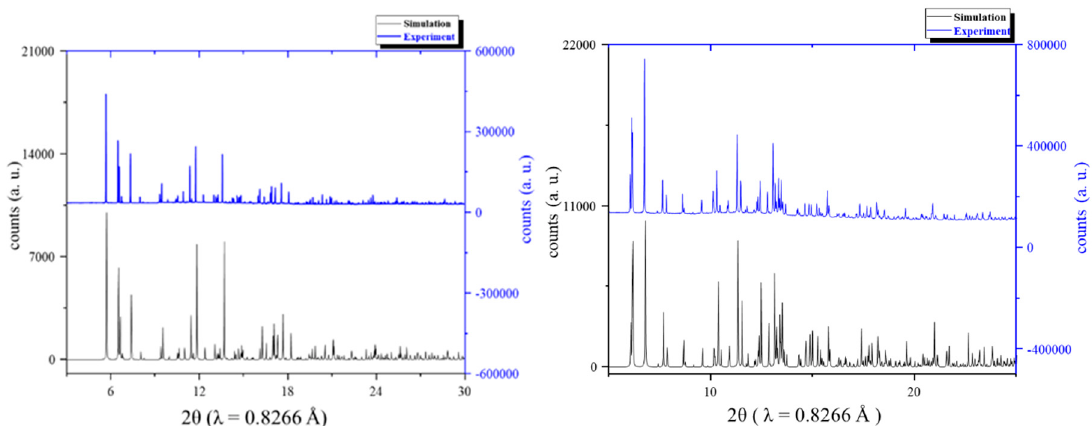
Figure 3. Synchrotron powder X-ray diffraction patterns of experimental data (blue) and simulation (black) for compounds 1 ( left ) and 2 ( right ).